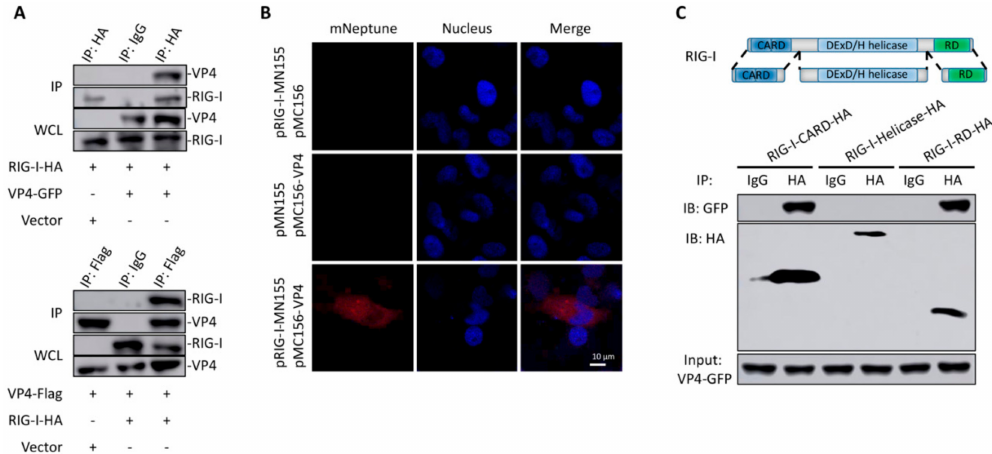
Figure 3. Identification of RIG-I as an interacting protein of VP4. ( A , B ) Verification of the interaction between VP4 and RIG-I via co-IP assay and bimolecular fluorescence complementation assay (BiFC). (A) Upper: FHM cells were co-transfected with VP4-eGFP / vector and RIG-I-HA for 48 h. Co-IP was performed with anti-HA monoclonal Ab and mouse IgG (control), and immunoblotted (IB) with the respective Abs. Below: FHM cells were co-transfected with RIG-I-HA / vector and VP4-Flag for 48 h. Co-IP was performed with anti-Flag monoclonal Ab and mouse IgG (control), and immunoblotted (IB) with the respective Abs. ( B ) Imaging of the VP4-RIG-I interaction by using far-red mNeptune-based BiFC in vivo. pRIG-I-MN155 and pMC156-VP4 were transfected alone or co-transfected into CIK cells under normal conditions. In the BiFC system, the fluorescence of the mNeptune channel was red and the nucleus was stained with DAPI. The images were acquired using confocal microscopy under a 40 × objective lens. Appearance of red fluorescence represents the positive